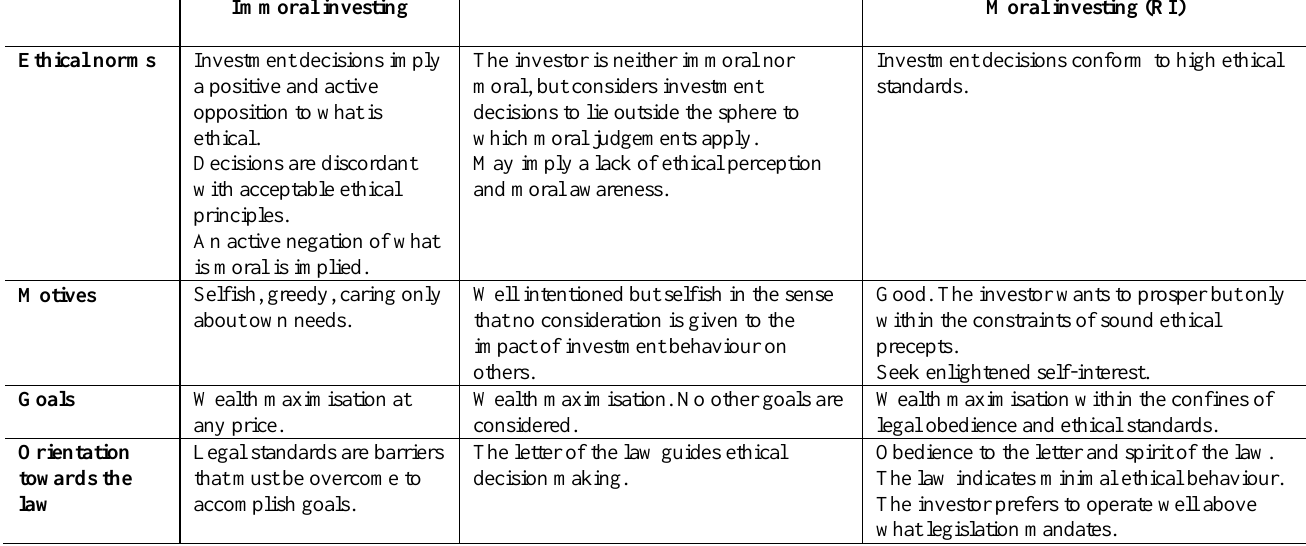
Table 1: Three types of investment